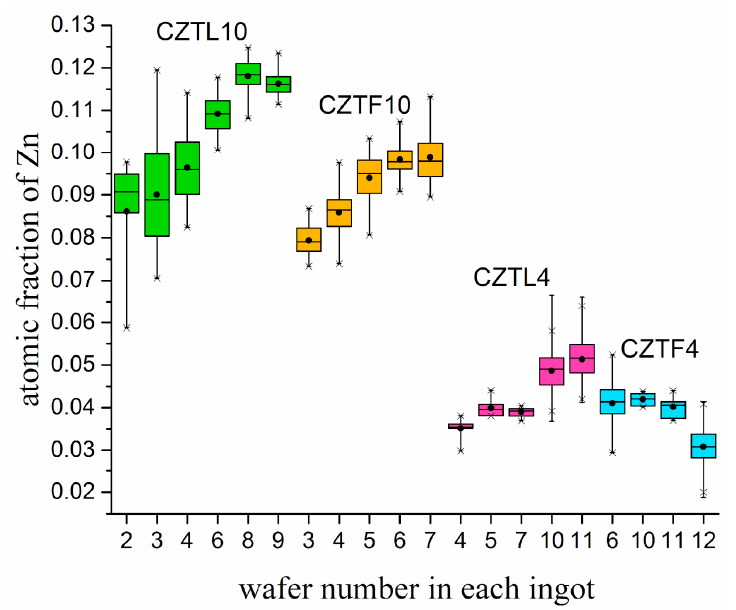
Figure 7. Zn atomic fraction in alloyed CdTe wafers. The total number “n” measurements (popula- tion) were on average around 80 for each wafer. This plot was built using Origin (Plot/Statistics/Box Chart).